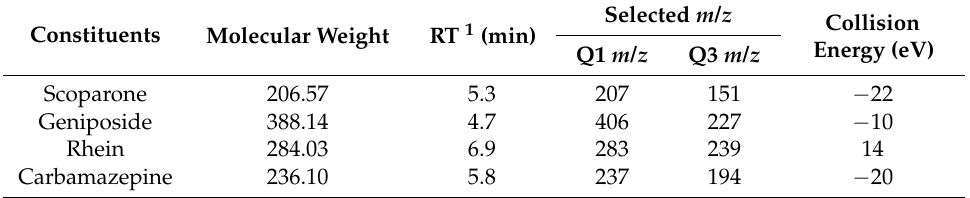
Table 1. The LC-MS/MS analytical conditions for the identification of the bioactive constituents.